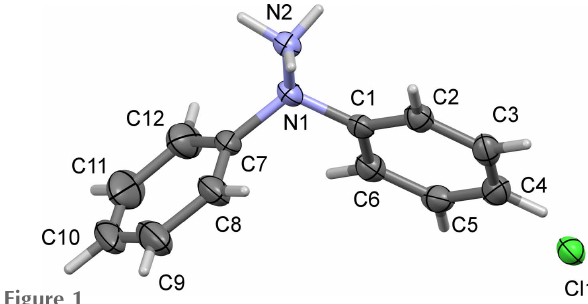
Figure 1 A view of the molecular structure of the title compound with atom labelling. Displacement ellipsoids are drawn at the 50% probability